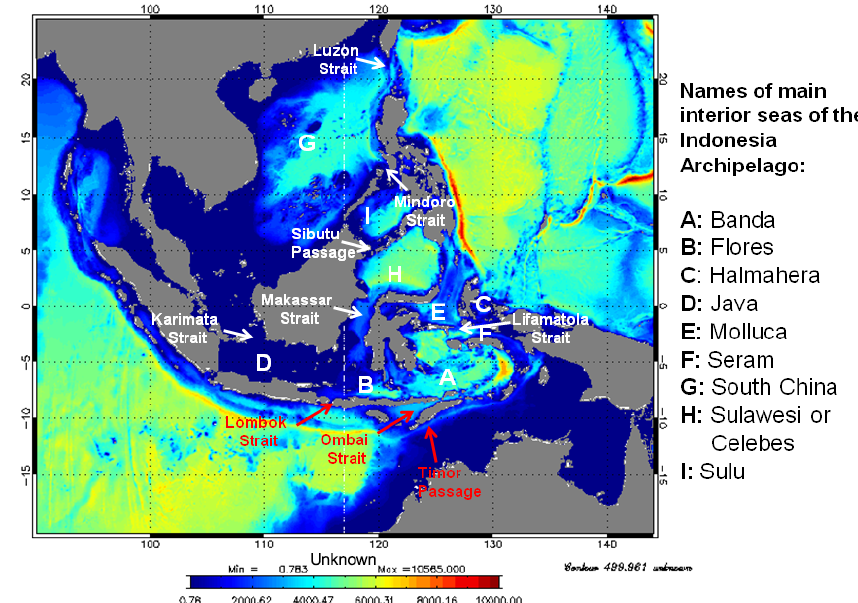
Figure 1. Bathymetry (in metre) of the INDO12 configuration (latitudes: 20 ◦ S–25 ◦ N and longitudes: 90–145 ◦ E) based on ETOPOV2g/GEBCO1 + in-house adjustments in straits of major interest. Three ITF exits are indicated in red. Main straits/passages are indicated in